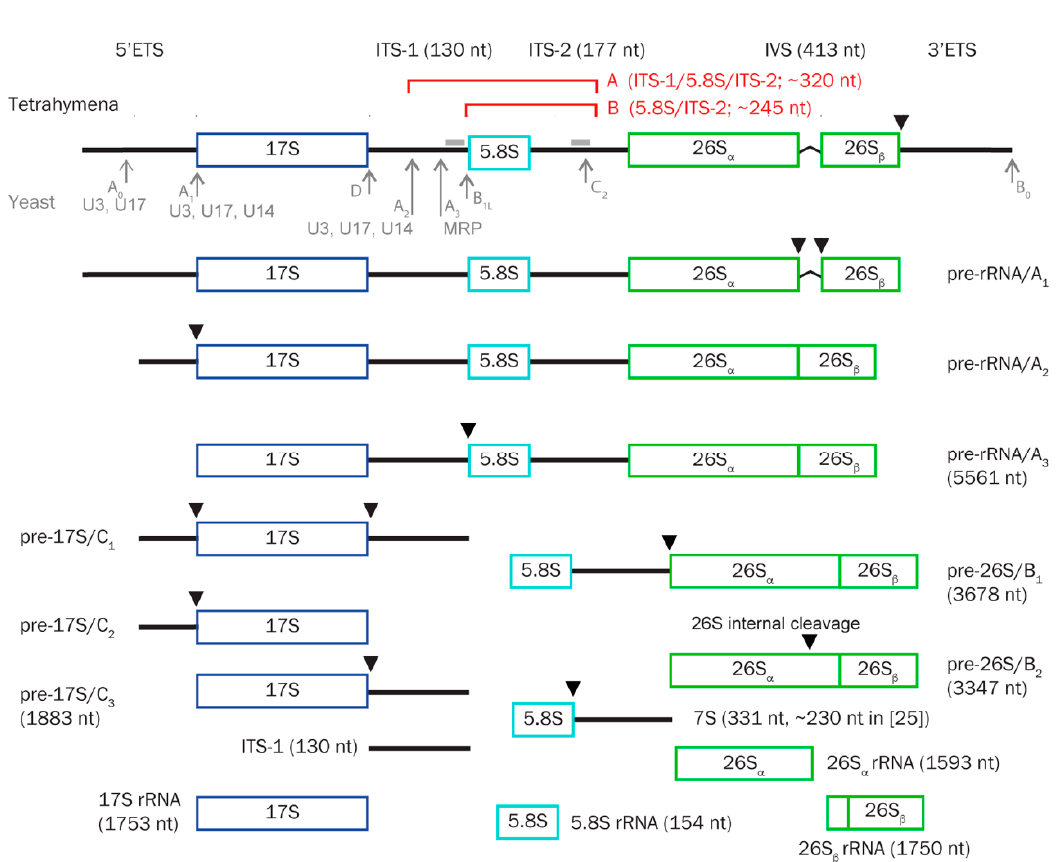
Figure 1. Pre-rRNA processing intermediates in Tetrahymena : Identified pre-rRNA species described in [25] are organized into a tentative processing scheme. Tetrahymena 17S corresponds to yeast/human 18S/18S, and 26S corresponds to yeast/human 25S/28S rRNAs. Inferred cleavage sites in Tetrahymena are indicated above the panels (black triangles) [25]. Endonucleolytic cleavages observed in yeast [1] are shown below the top panel for comparison (grey arrows). For cleavages involving recognized essential snoRNAs U3/snR17, U14/snR128, U17/snR30, and MRP the implicated RNAs are noted at the respective sites in grey. Brackets in red indicate the inferred positions of the two intermediates (A and B) that accumulate in TtnuCD32 KD cells. The approximate sizes of A and B are noted. Sizes of pre-RNAs based on the rDNA sequence (acc. no. X54512) and [25] are noted by the RNA when applicable. Two Tetrahymena -specific features are included, a self-splicing group I intron (IVS) in 26S and an internal processing site in 26S that process this RNA species into two fragments (26S α and 26 β ) that both co-migrate with 17S in gel electrophoretic analysis. ETS and ITS: External and internal transcribed spacers. IVS: self-splicing group I intron. Grey bars indicate the positions of probes used in the northern blot analysis in Figures 3, S3 and S4.